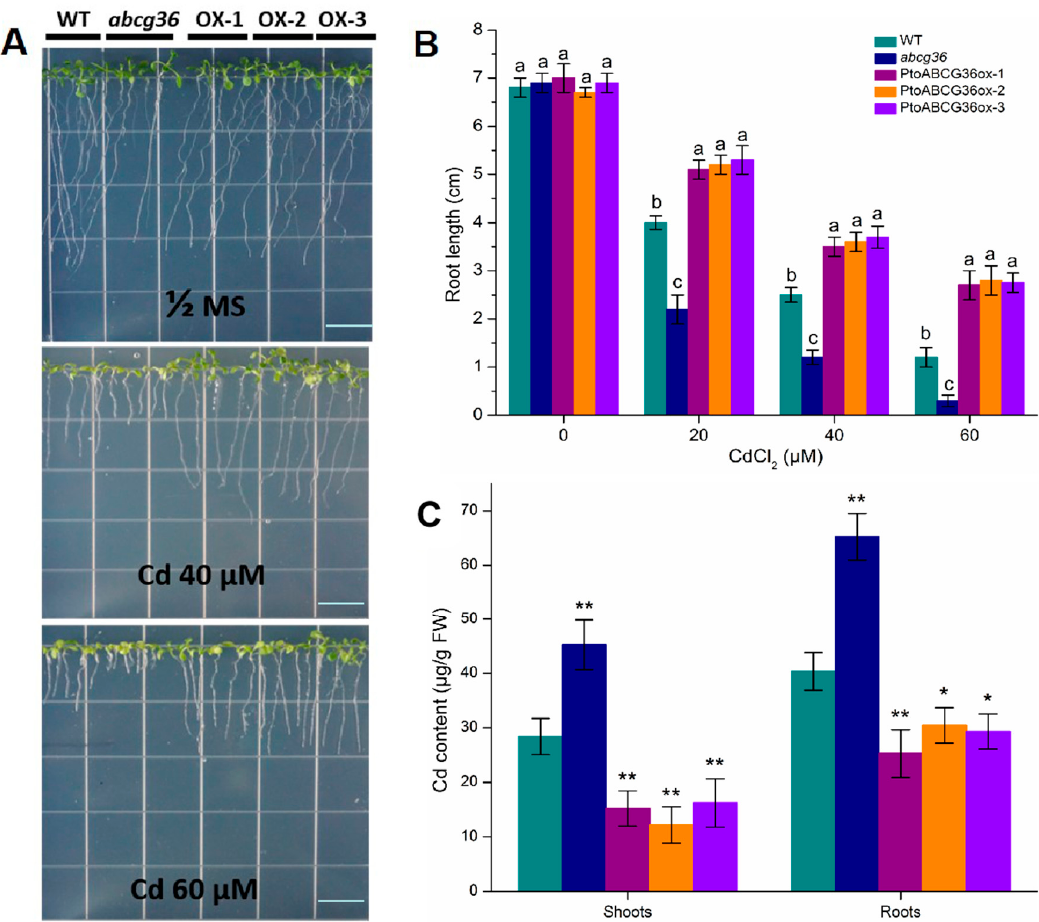
Figure 5. PtoABCG36 enhances cadmium tolerance in Arabidopsis. Arabidopsis seeds were grown on half-strength MS medium containing 0, 40 or 60 µM CdCl 2 for two weeks ( A ) and primary root length ( B ) were analyzed. ( C ) Accumulation of cadmium in plants after treatment with the half MS liquid medium containing 100 µM CdCl 2 for 24 h. For root lengths, n = 120–124 from three independent experiments. WT, wild-type; abcg36 , abcg36 mutant SALK_1422526; OX-1 and OX-2, OX-3 PtoABCG36 -overexpressing Arabidopsis lines. White bars = 15 mm. Cd concentrations in plants were measured by ICP-OES. Error bars indicate standard deviation. Different letters indicated significant differences ( p < 0.05). Student’s t-test, * p < 0.05, ** p < 0.01.